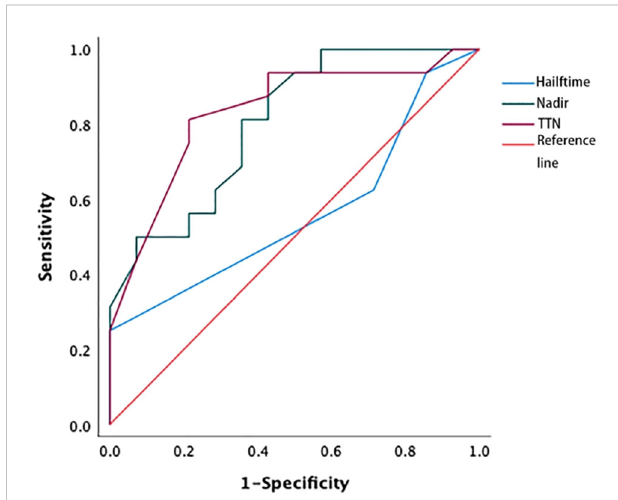
FIGURE 1 ROC curve of nPSA, TTN, and PSA halving time. The areas under the curve for the PSA nadir and PSA time to nadir were 0.804 and 0.833, respectively, while AUC for the PSA halving time was 0.563. ROC, receiver operating characteristic; TTN, time to PSA